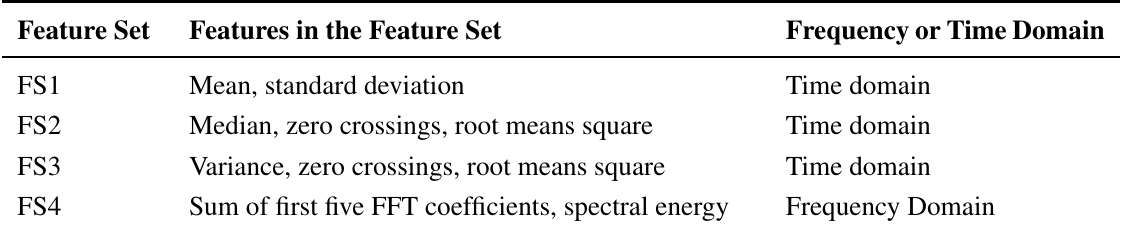
Table 1. Feature